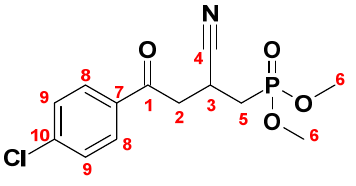
Figure 4. The structure of compound 5d .